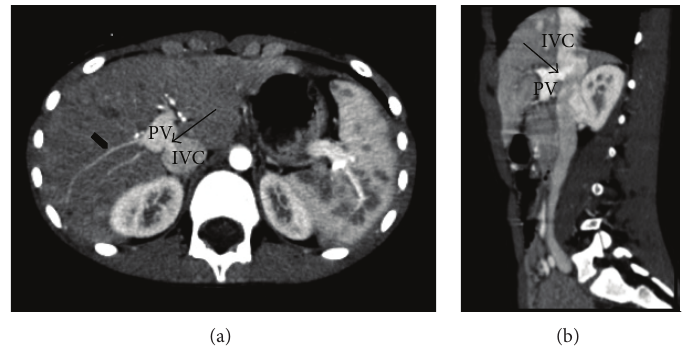
Figure 1: Contrast-enhanced CT images. Axial projection (a); sagittal-oblique projection (b). The arrows in (a) and (b) show a shunt between the posterior wall of the portal vein (PV), just before its intrahepatic hilar division, and the inferior cava vein (ICV); the intrahepatic portal branches appear reduced and filiform (arrowhead in